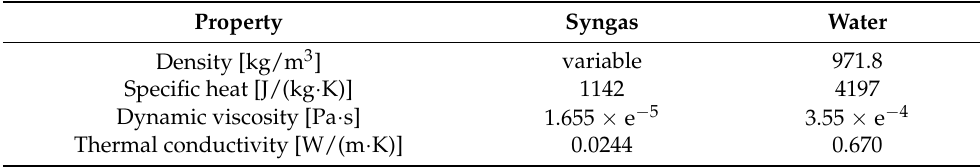
Table 3. Thermophysical properties of syngas and water.